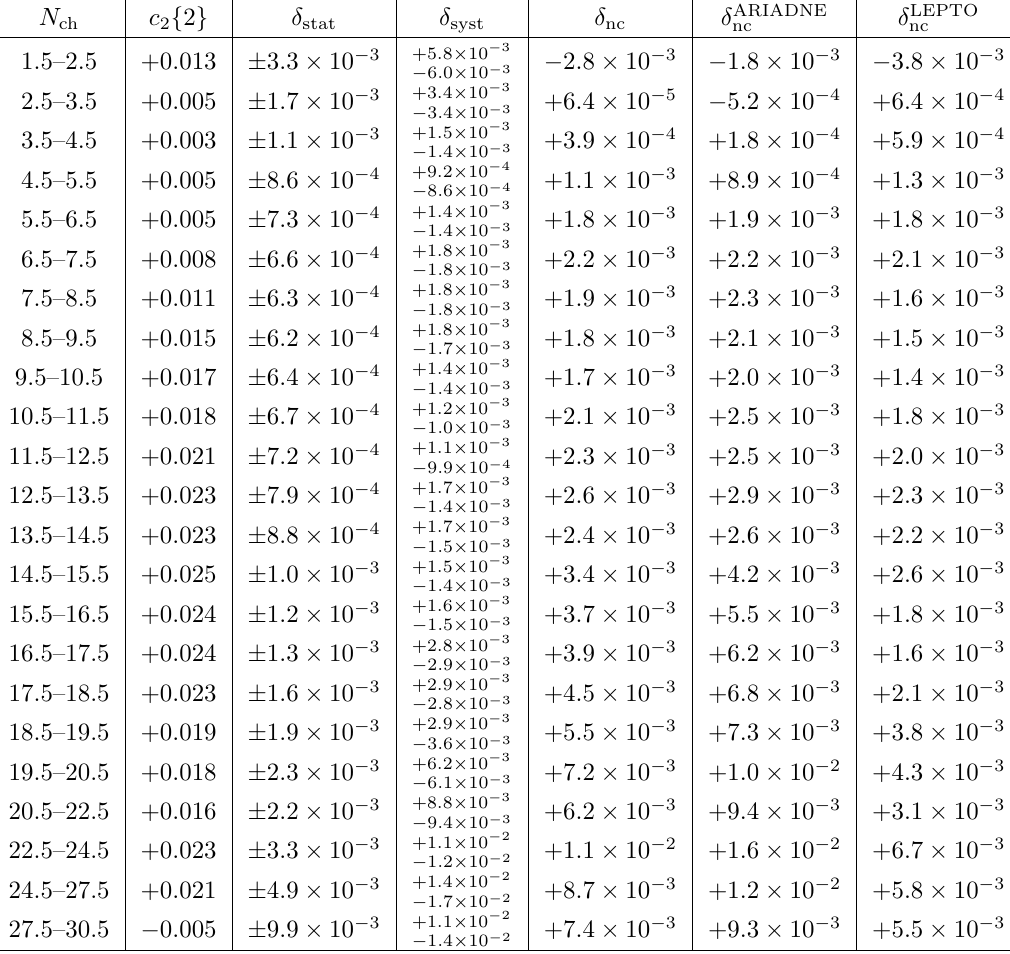
Table 6 . c 2 f 2 g versus N ch from (cid:12)gure 7 (b) and (cid:12)gure 10 (d), p T > 0 : 5 GeV, j (cid:1) (cid:17) j > 2; (cid:14) stat , (cid:14) syst and (cid:14) nc denote the statistical, systematic and Monte Carlo non-closure uncertainties,